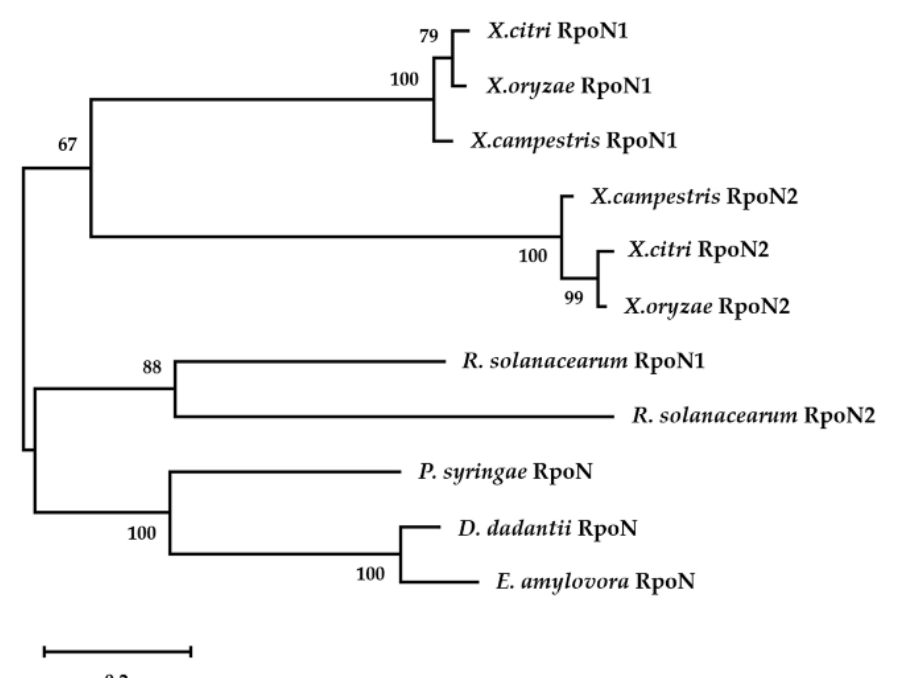
Figure 2. Phylogenetic analysis of RpoN. Eleven full ‐ length RpoN protein sequences of X. oryzae , X. citri , X. campestris , R. solanacearum , P. syringae , D. dadantii , and E. amylovora were downloaded from the National Center for Biotechnology Information. A maximum likelihood (ML) tree was generated using MEGA ‐ X with 1000 bootstrap values. Values on each branch represent the corresponding bootstrap probability. The scale bar indicates the number of amino ‐ acid substitutions per site.